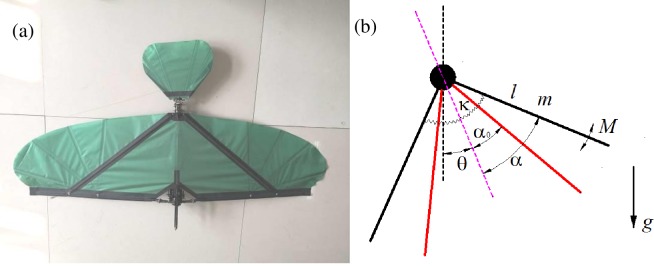
The bird-like flapping wing robot and its simplified physical model.